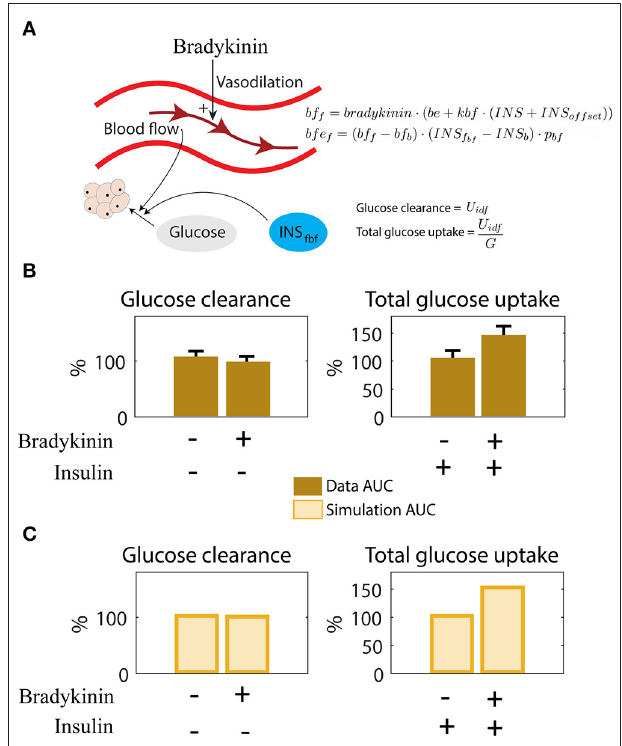
FIGURE 4 | Interaction between blood flow and insulin on adipose glucose uptake. (A) Illustration of blood flow and insulins effect on adipose tissue glucose uptake. Bradykinin increases the blood flow. The new equations for blood flow ( bf ), dependent on bradykinin ( bradykinin ), and blood flow effect ( bfe f ), dependent on blood flow dependent insulin in fat tissue ( INS fbf ). The parameters changed/added here are bf b , bradykinin , be , p bf , and INS b . See Supplementary Table 4 for description and value. (B) Behavior seen in data as response to insulin and Bradykinin. Insulin alone has a relatively small effect on glucose clearance, but increases glucose uptake significantly when combined with Bradykinin ( Iozzo et al., 2012). (C) The same behavior as in (B) ( Iozzo et al., 2012) can be simulated with the model. Adding Bradykinin is simulated by increasing the value of bradykinin , and adding insulin infusion is simulated by increasing the value of INS offset from